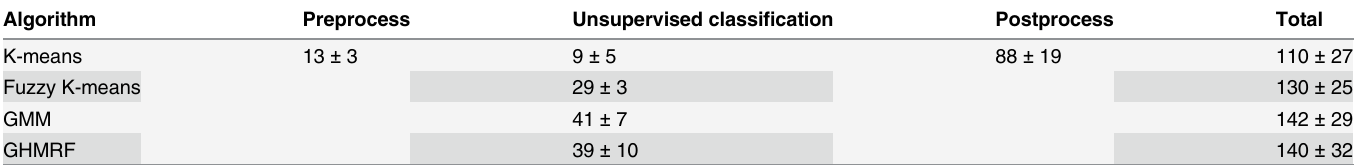
Table 5. Average computational times in minutes for the whole segmentation pipeline for a single